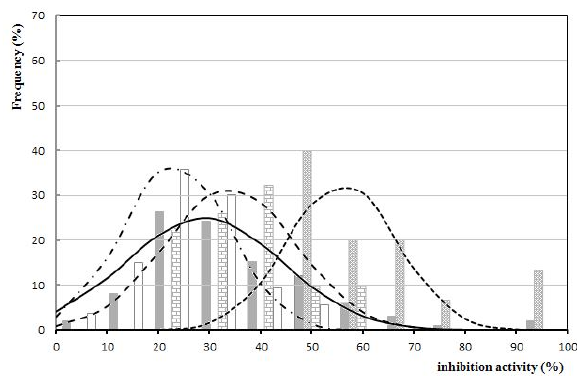
Figure 13: Distribution of inhibitory activity to catepsin B in oat extracts expressed as % of inhibitory activity (solid column and solid line – complete set, r 2 = 0.901, bracket column and dash line – minor red subset, r 2 = 0.648, dots column and dash-and-dot line – major green subset, r 2 = 0.902, empty column and dots line – major blue subset, r 2 = 0.987, the mentioned colors correspond to the colors in Fig. 7 and Fig.